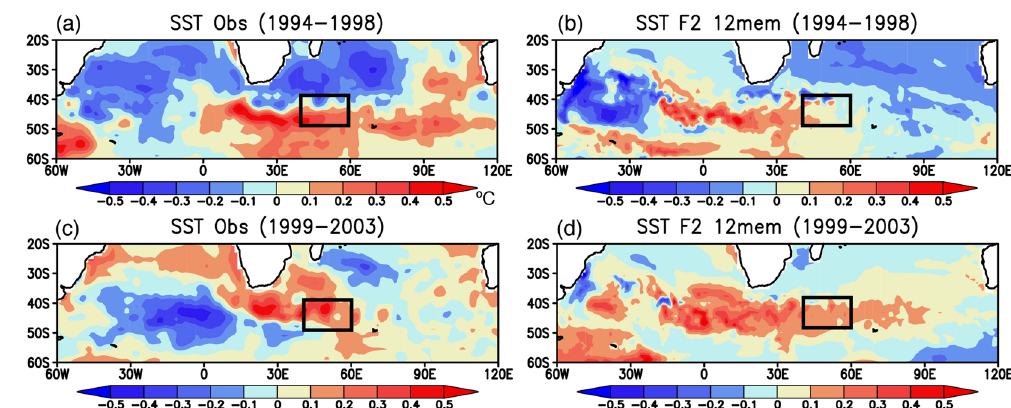
Figure 3. ( a , c ) 5-yr mean SST anomalies (in °C) observed during 1994–1998 and 1999–2003, respectively. The black boxes indicate the region where the SWIO index was calculated. ( b , d ) Same as in ( a , c ), but for the reforecast experiments initialized from March 1st 1994. Here we show 12 ensemble mean SST anomalies. The maps were generated using Grid Analysis and Display System (GrADS) Version 2.1.a3 (http://cola.gmu.edu/